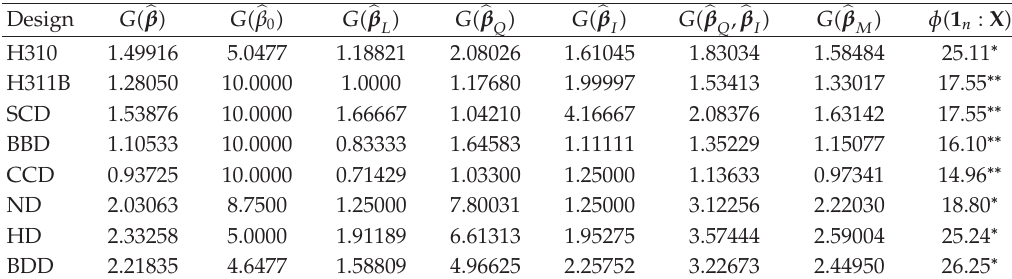
Table 1: Roots G (cid:5) (cid:2) β (cid:6) and G (cid:5) (cid:2) β (cid:6) of generalized variances for (cid:2) β and subset estimators { (cid:2) β i φ (cid:5) 1 n : X (cid:6) deg between regressors and the constant, against reference values φ ∗∗ < 18 . 44 and φ ∗ < 30 . 00, in eight small second-order designs.